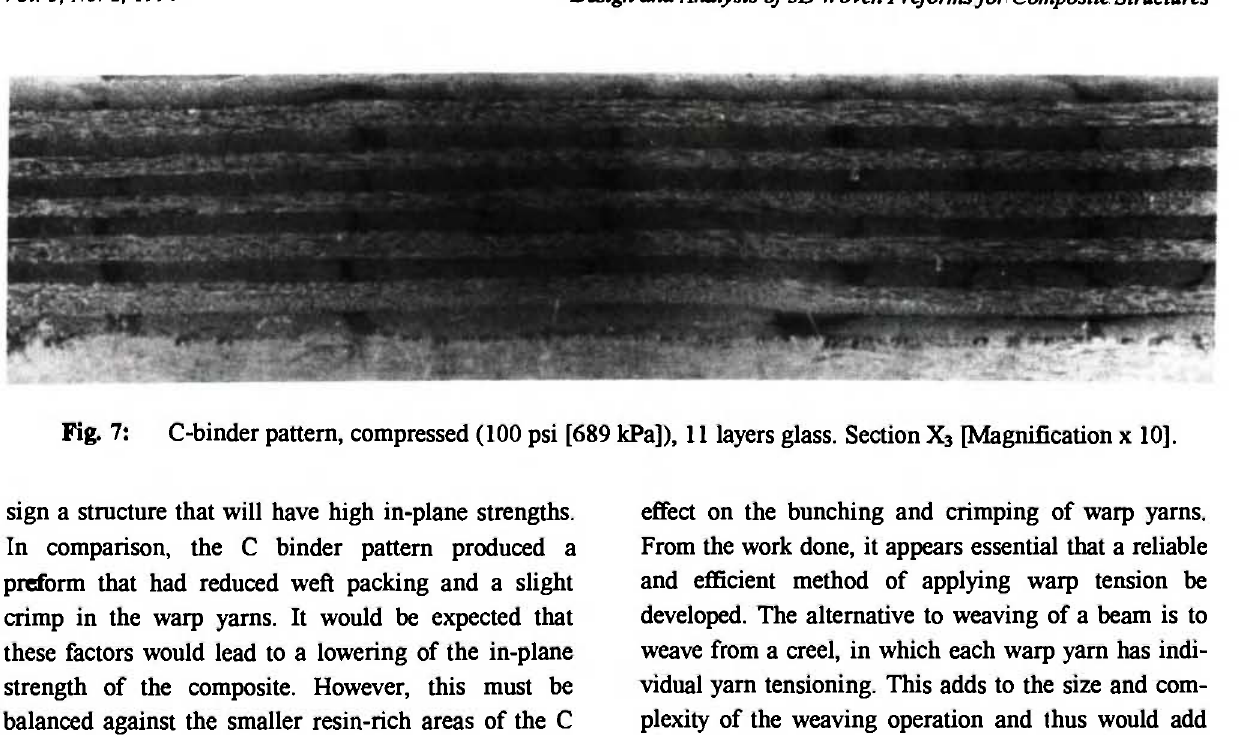
Fig. 7: C-binder pattern, compressed (100 psi [689 kPa]), 11 layers glass. Section X